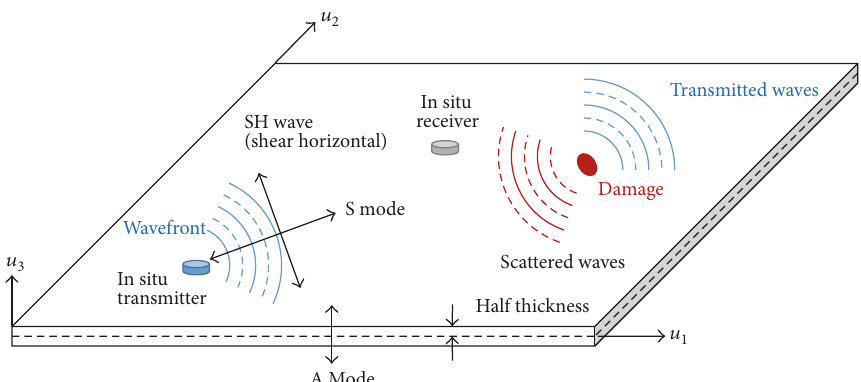
Figure 1: Propagating waves in thin-walled structures.